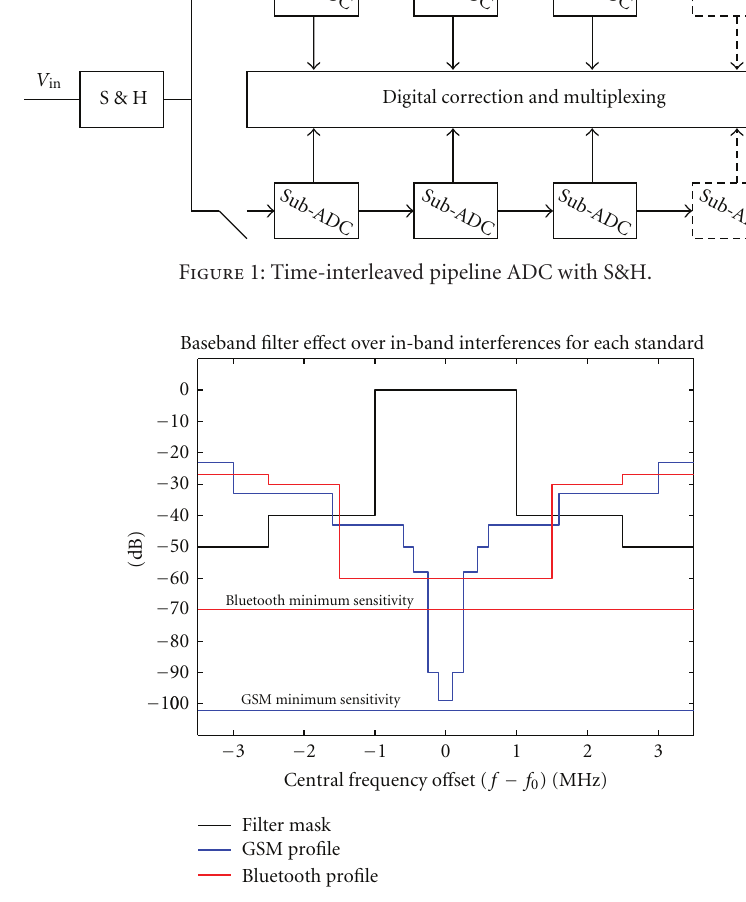
Figure 2: Blocker profiles for 2 wireless standards.